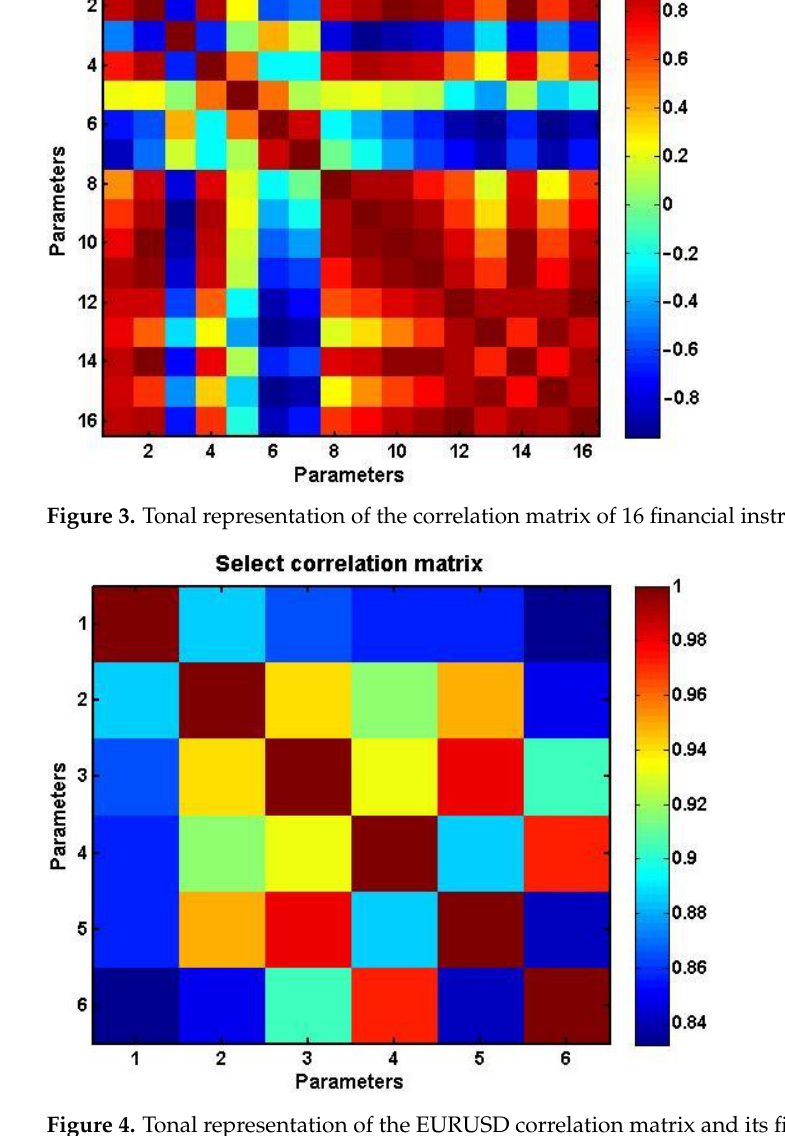
Figure 3. Tonal representation of the correlation matrix of 16 financial instruments. Table 1. Financial instruments and their respective numbers.